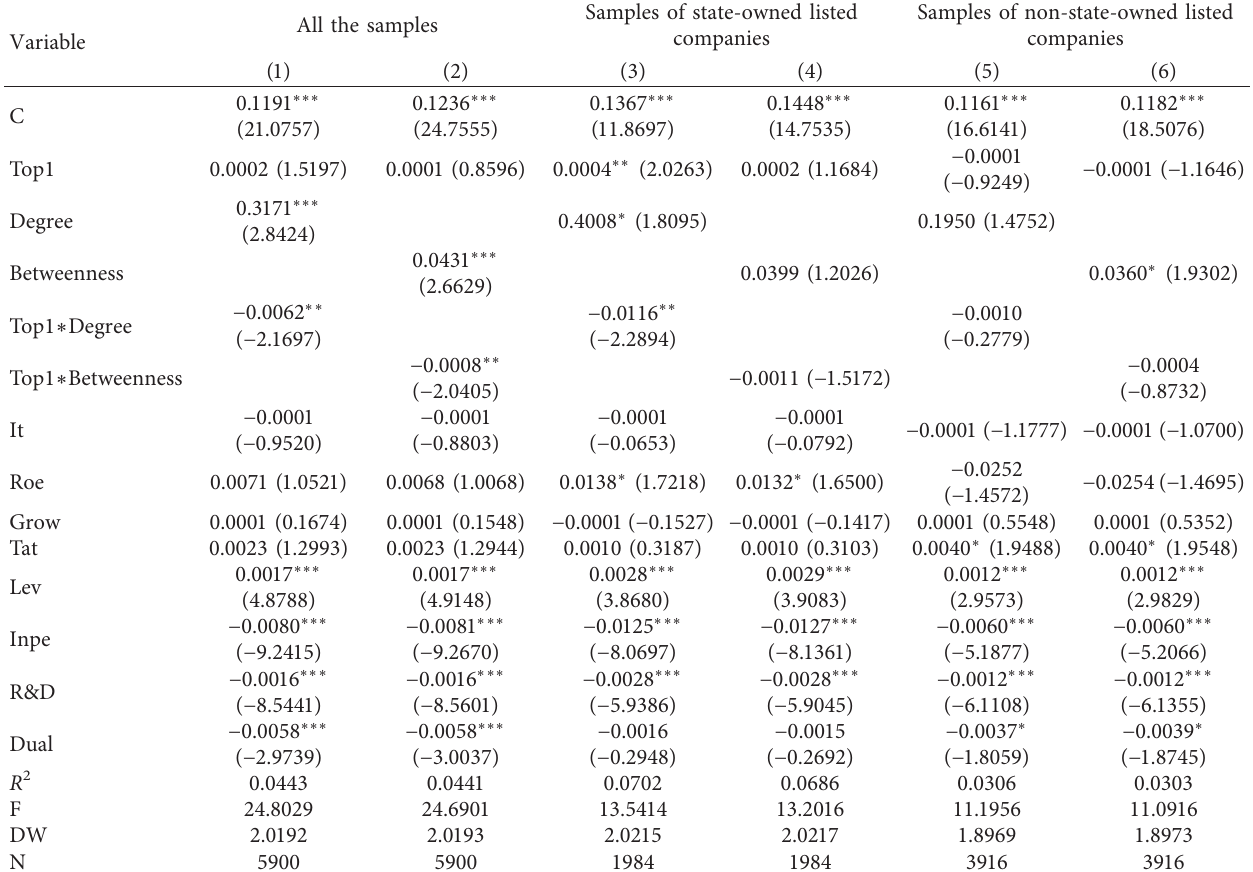
Table 6: Regression results: director networks, equity concentration, and cost of equity